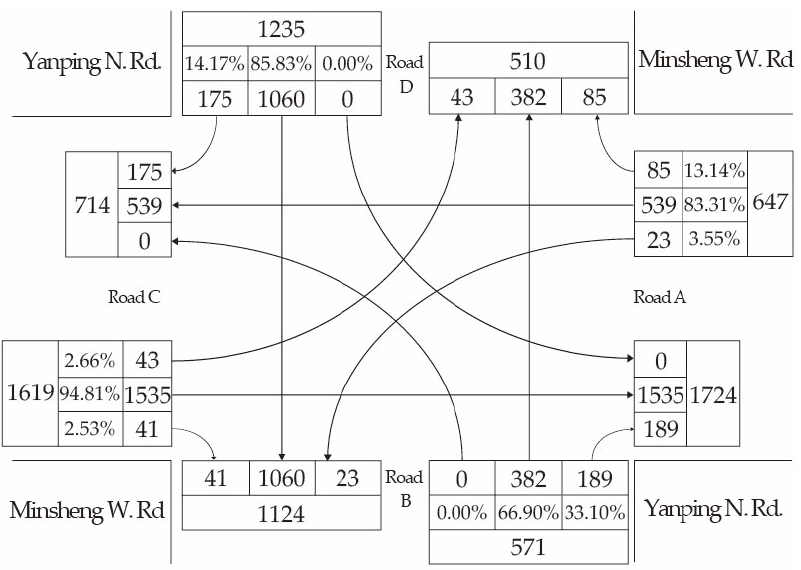
Figure 6. Road traffic data of Huanhe N. Rd and Nanjing W. Rd. ( a ) 8:00 a.m. to 9:00 a.m. ( b ) 5:00 p.m. to